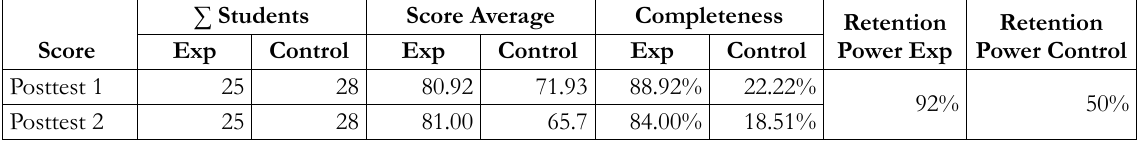
Table 5. Comparison results of posttest 1 and posttest 2 scores of the experimental group and the control